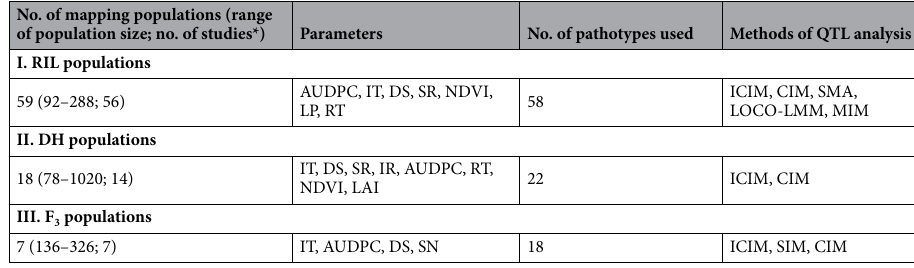
Table 1. A summary of QTL studies used for MQTL analysis (Details are provided in Supplementary Table S1). RIL recombinant inbred line, DH doubled haploid, AUDPC area under disease progress curve, IT infection type, DS disease severity, SR stripe rust response, NDVI normalized difference vegetation index, LP latency period, RT reaction type, IR infection response, LAI leaf area infected, SN number of stripes per 10 cm 2 leaf area, ICIM inclusive composite interval mapping, CIM composite interval mapping, SMA single marker analysis, LOCO-LMM leave one chromosome out-linear mixed model, MIM multiple interval mapping, SIM simple interval mapping. *In one of the studies, two different populations, i.e. RIL and DH, both are used. Therefore, this study is counted two times, i.e., in I and